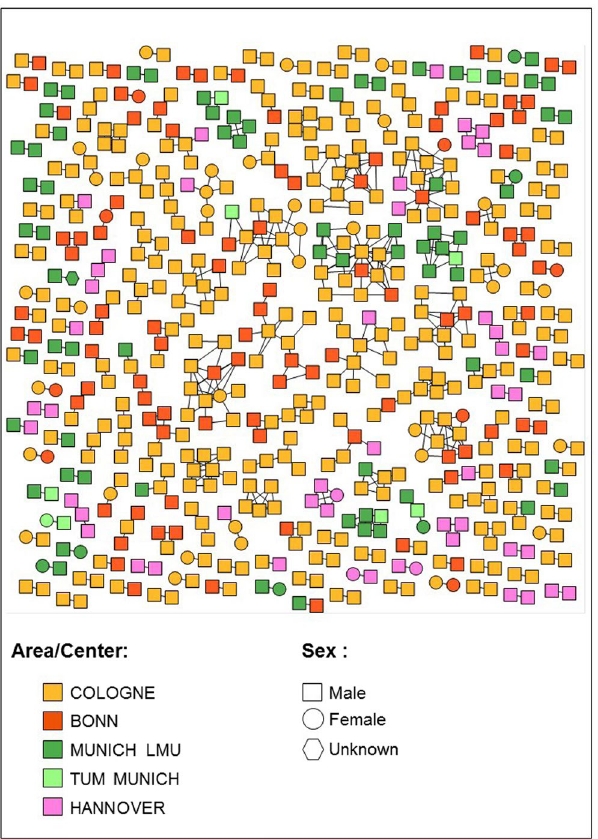
Figure 2. HIV Transmission Network by Center and Region. Individuals (nodes) are shaped as square (men) and circle (women). Nodes are coloured according to the region where they have been identified in yellow (Cologne), red (Bonn), dark green (Munich LMU), light green (TUM Munich) and pink (Hannover). All edges represent a genetic distance ≤ 1.5% separating